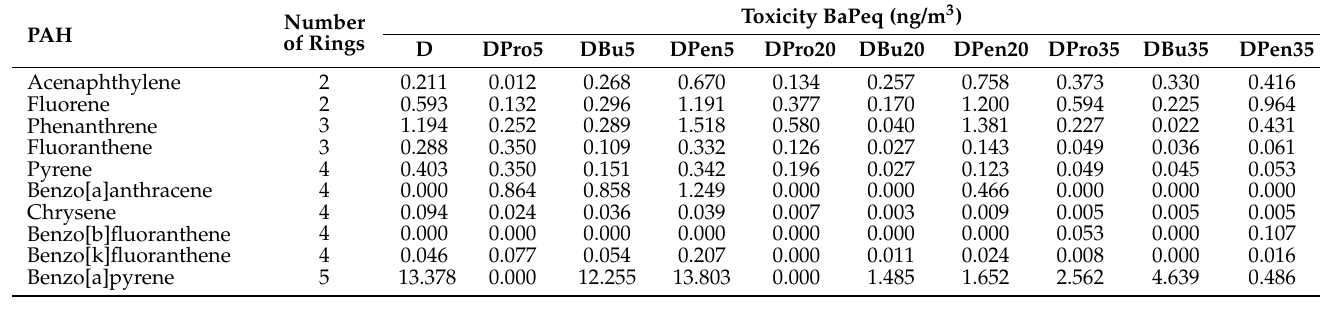
Table 6. Toxicity BaPeq concentration in exhaust gas.